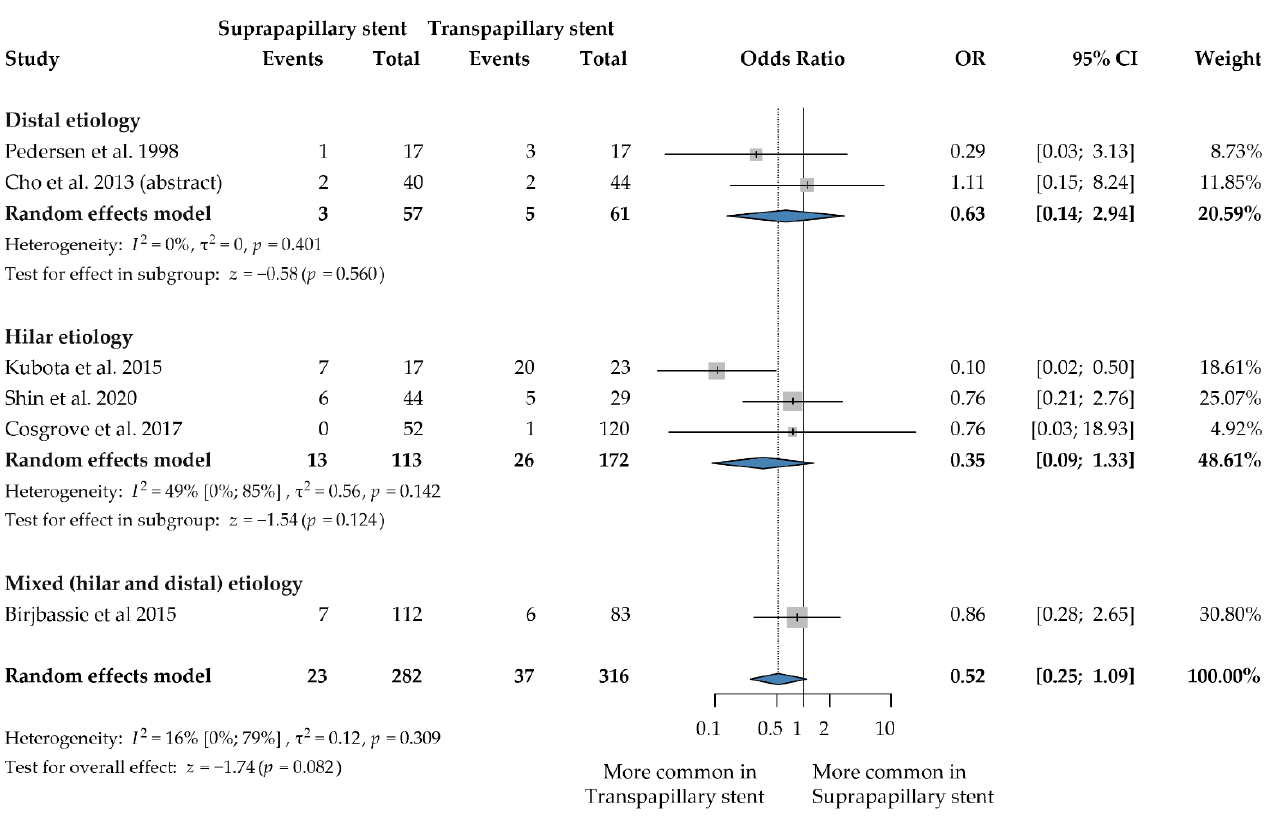
Figure 4. Forest plot comparing cholangitis rate between suprapapillary and transpapillary stents.